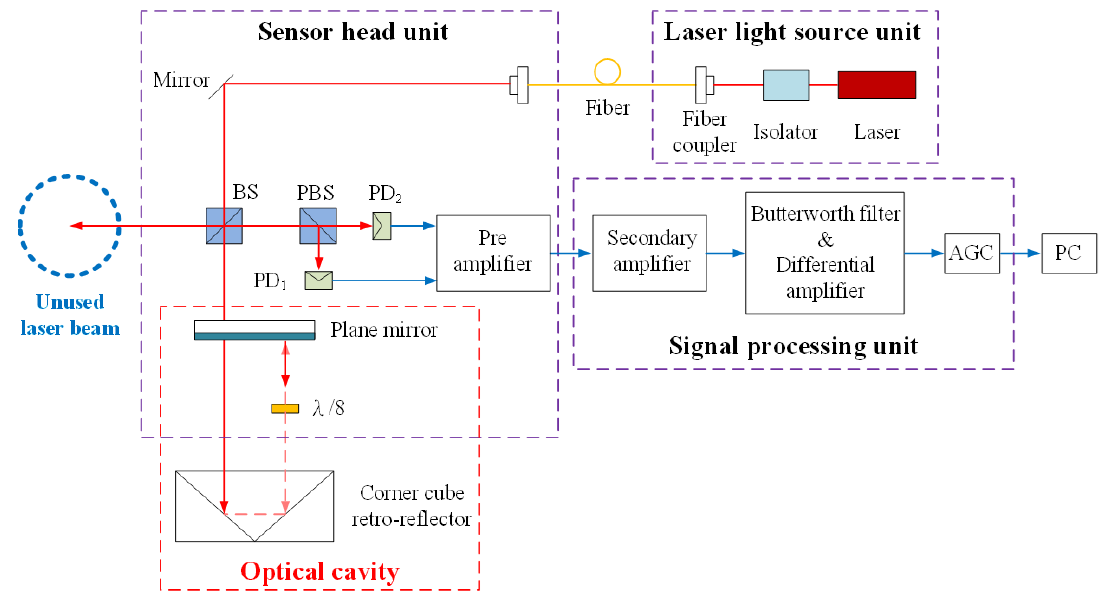
Figure 2. Proposed folded Fabry–Pérot interferometer.